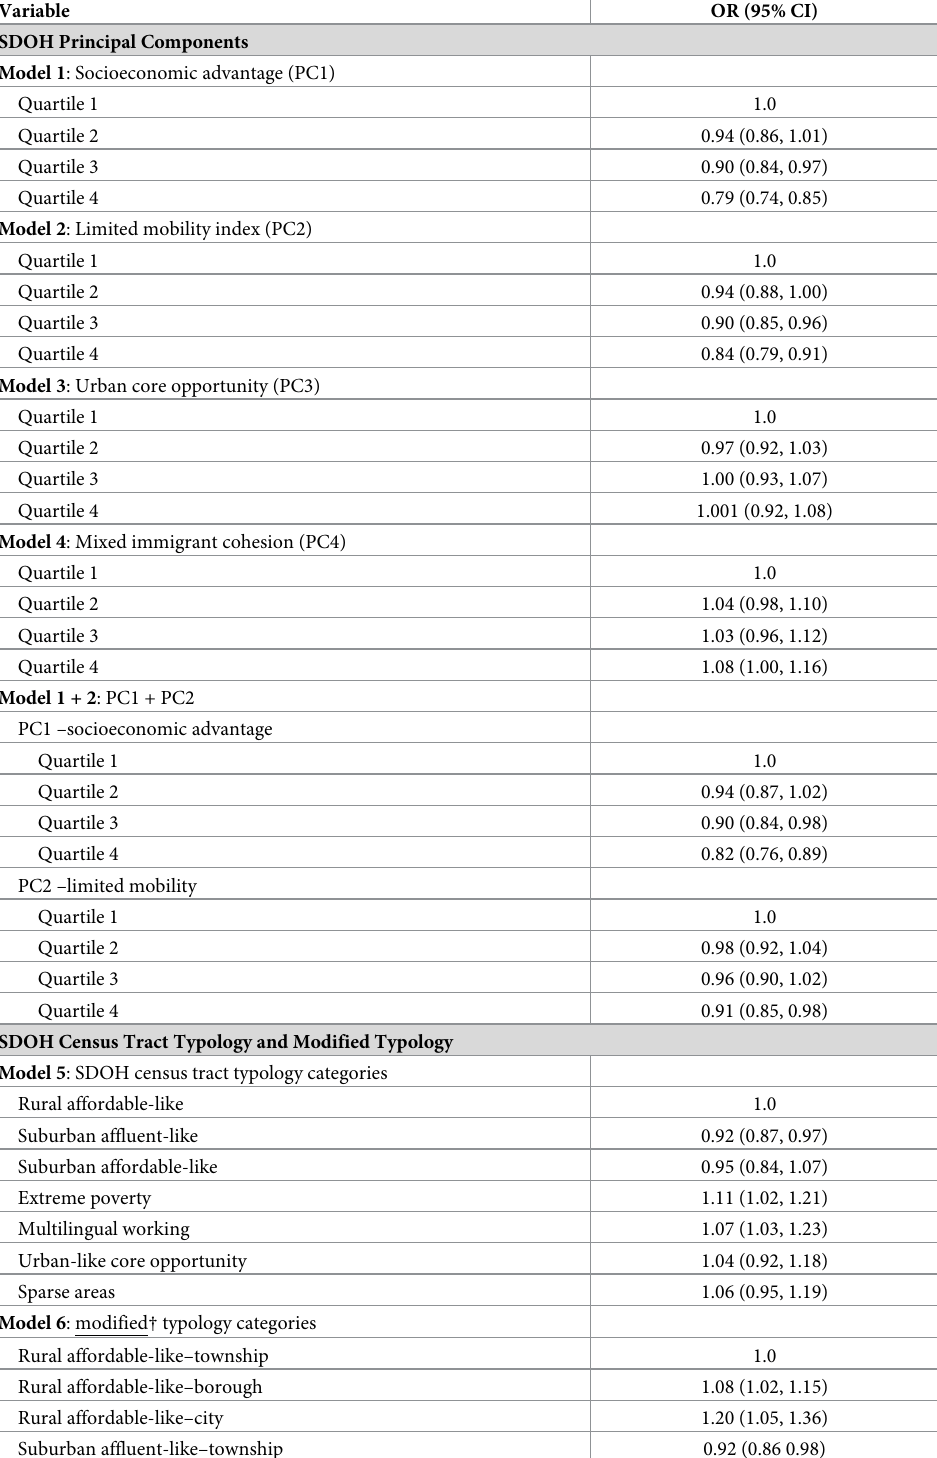
Table 5. Adjusted � associations of SDOH principal components, SDOH census tract typology, and modified com- munity typology from separate models with new onset T2D